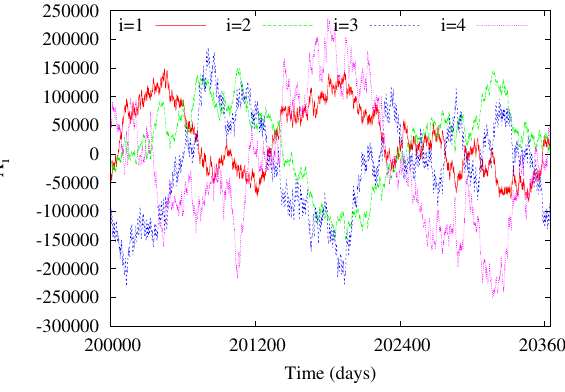
Fig. 1. Temporal evolution of the four modes of A i for θ ∗ = 0 . 14 and δ = 0 . 001938 . figure